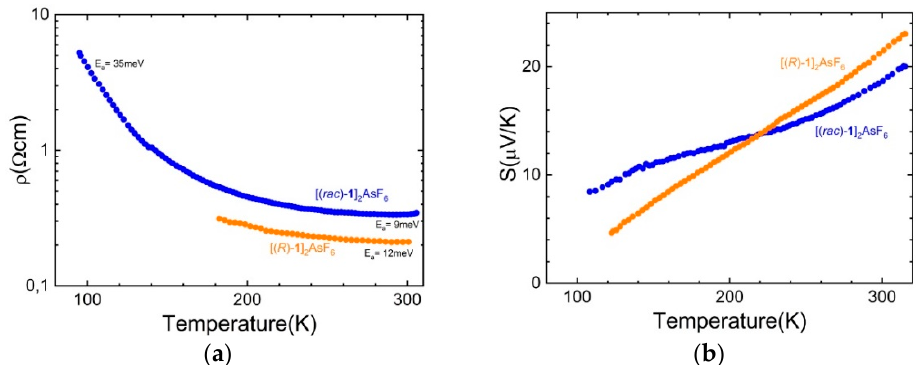
Figure 3. ( a ) Temperature dependence of the electrical resistivity ρ for single crystals of [(rac)- 1 ] 2 AsF 6 (blue curve) and [(R)- 1 ] 2 AsF 6 (orange curve) measured using four-in-line contacts; ( b ) Temperature dependence of the thermoelectric power for a single crystal of [(rac)- 1 ] 2 AsF 6 (blue curve) and [( R )- 1 ] 2 AsF 6 (orange curve).